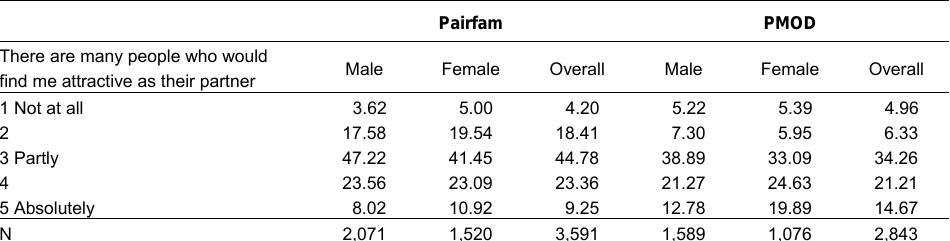
Table 2 : Self-assessed attractiveness in respondents from the pairfam versus PMOD surveys (column-wise percentages) Pairfam